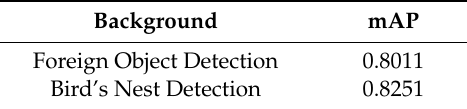
Table 3. Comparison in di ff erent backgrounds.